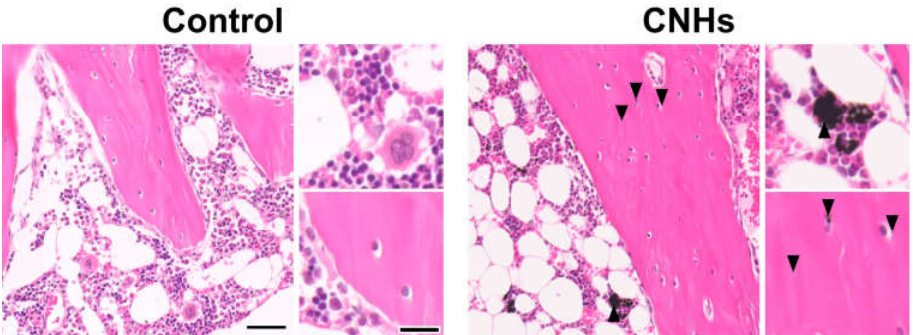
Figure 10. Distribution of CNHs in bone tissue. Representative image of tibial tissue specimens of the control and CNH rats stained with hematoxylin eosin. Arrowheads indicate CNHs. Scale bars: 2 µm (each left panels) and 500 nm (each right panels). Histological analysis was performed 12 weeks postoperatively.